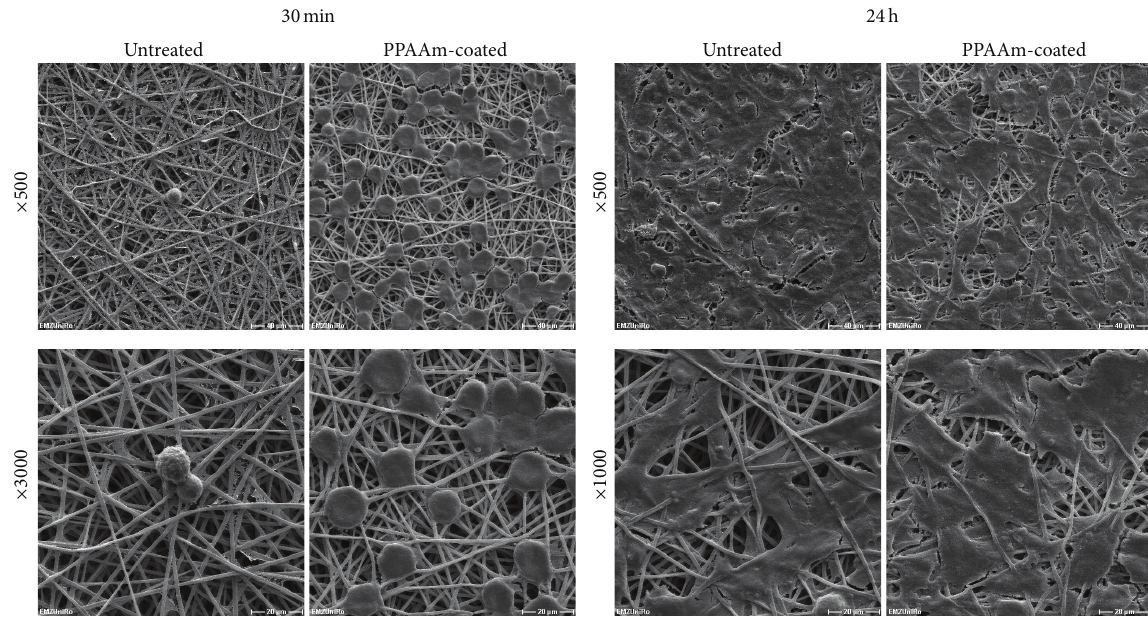
Figure 8: SEM images showing spreading of Ca9-22 human gingiva epithelial cells on untreated and PPAAm-coated PLA fiber meshes after 0.5 and 24 h (bar = 40 𝜇 m (upper row) and 20 𝜇 m (lower